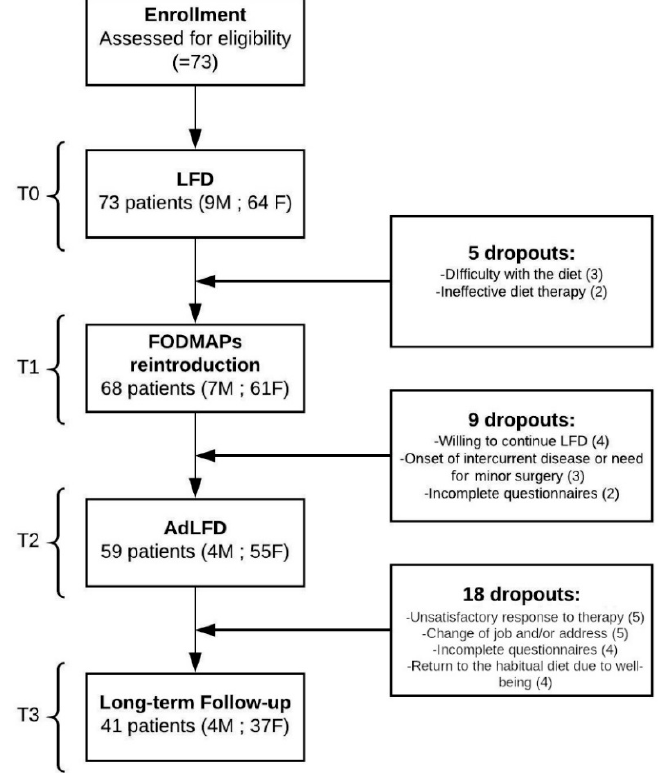
Figure 1. Study design. LFD: Low-FODMAP Diet, FODMAP: fermentable oligosaccharides, disaccharides, monosaccharides and polyols, AdLFD: Adapted Low-FODMAP Diet. The boxes on the right show the number of dropouts and the reasons for them are reported at each time.